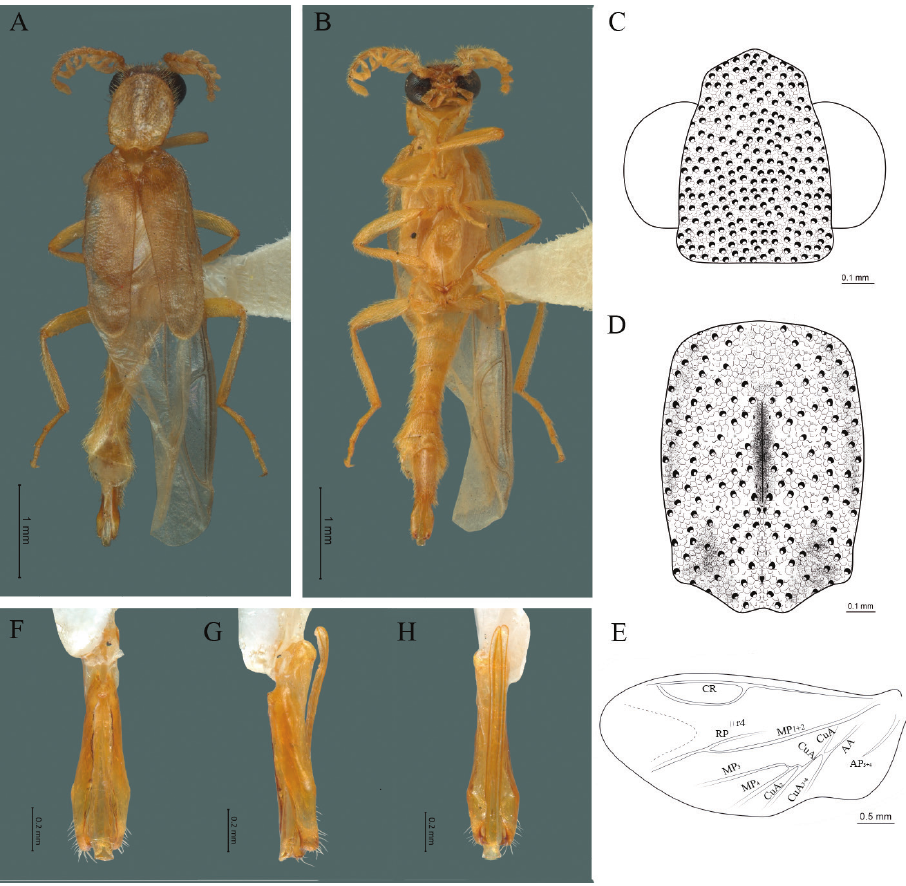
Figure 6. Cenophengus ciceroi Wittmer, 1981, male. Habitus: A dorsal B ventral C head dorsal D prono- tum dorsal E hind wing. Wing venation: CR = Radial Cell; r4 = radial 4 vein; RP = Posterior Radia vein l; MP1+2 = Posterior Median vein; CuA = Cubital vein; AP = Posterior Anal vein. Aedeagus: F dorsal view G lateral view H ventral